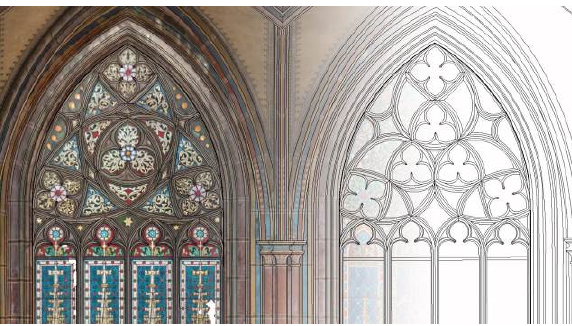
Figure 23. Detail of pointcloud and model of the interior